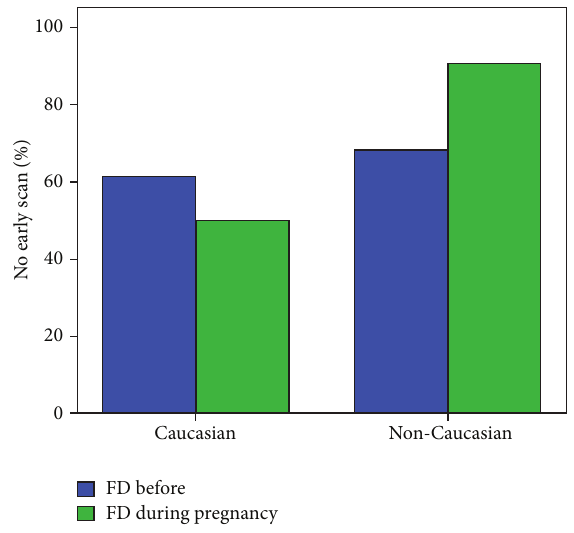
Figure 1: Percentage of women, who had no early scan and factors involved (FD = first diagnosis).